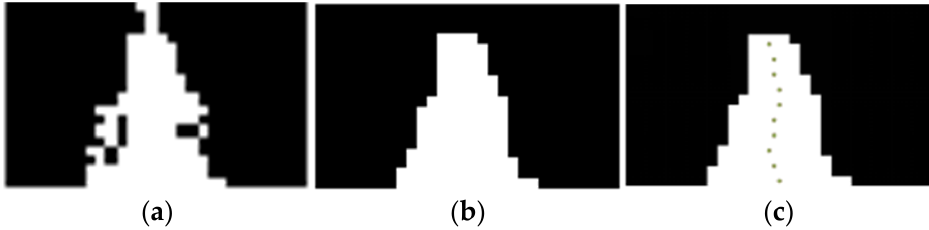
Figure 5. The processed images of male OSR plant feature region; ( a ) The sequence image; ( b ) The denoised image; ( c ) The feature point image.